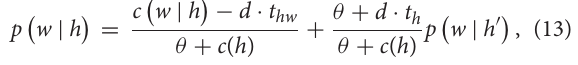
generated similar to the bigram distribution, such that G W PY( G W , θ , d ). In general, then, the n -gram model is Pitman- 2 Yor distributed with base measure from the ( n − 1)-gram model, and the base measure of the unigram model being G W